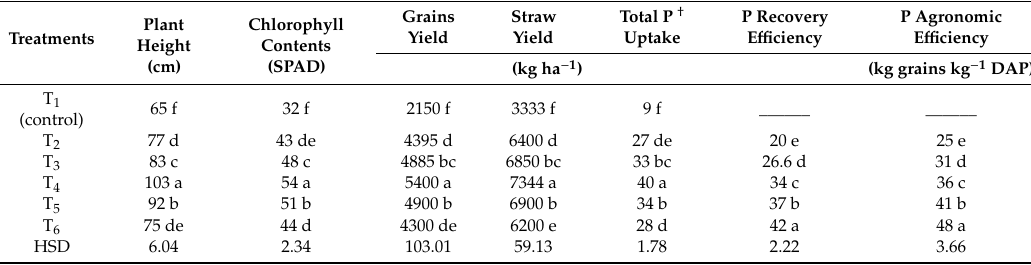
Table 3. E ff ect of polymer-bioaugmented PsJN coated DAP on yield contributing attributes of wheat in field